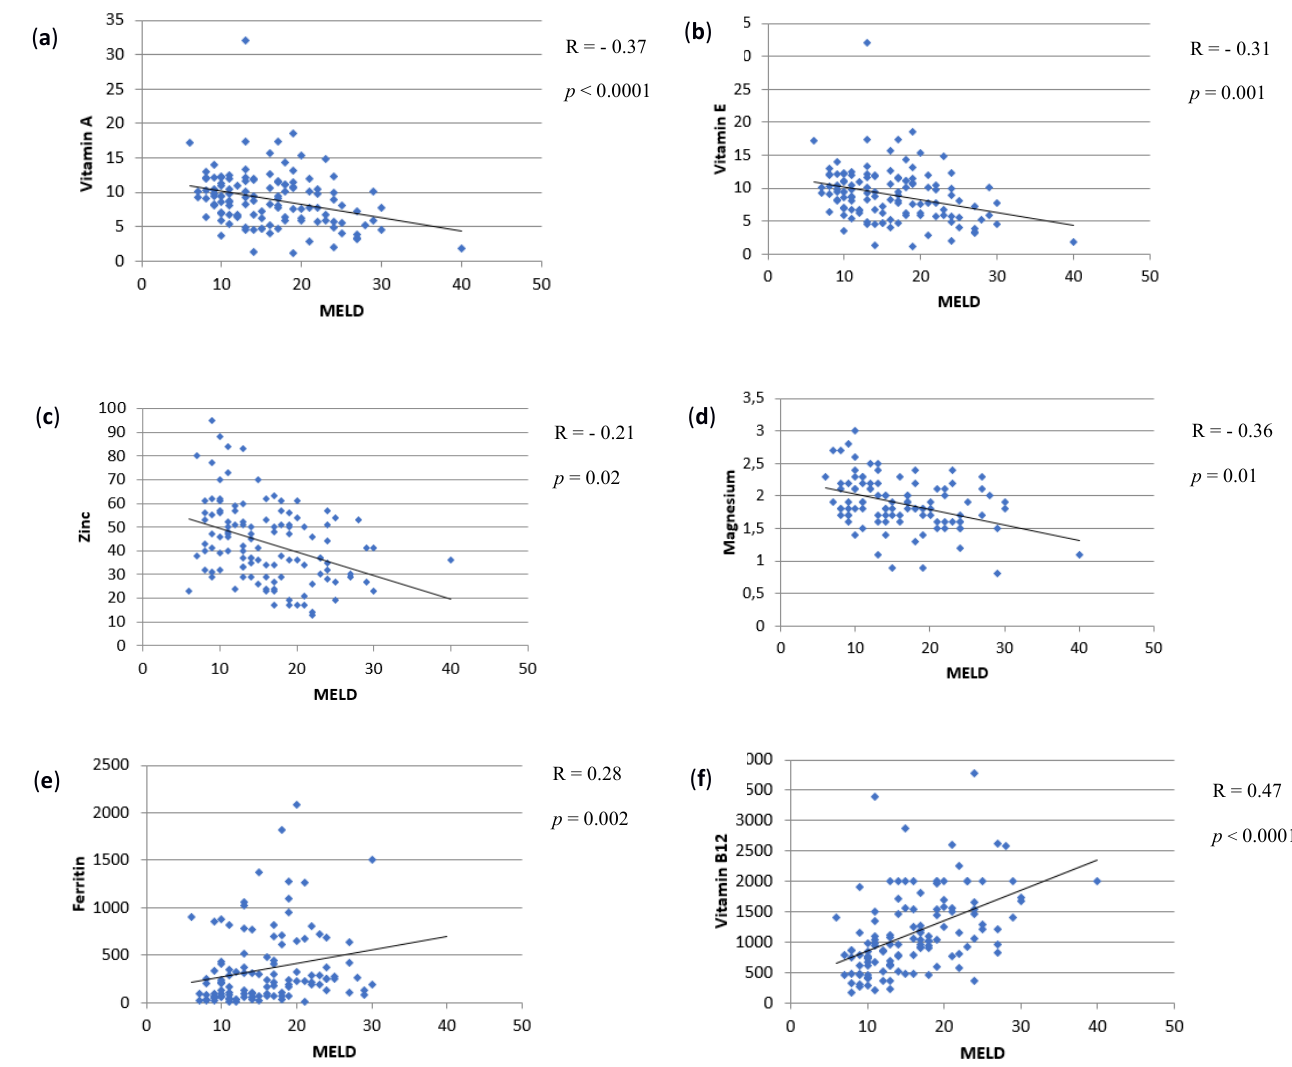
Figure 2. Scatter plots of the correlations of MELD score with the micronutrients that reached statistical significance. R is the correlation coefficient. ( a ) MELD score and vitamin A (negative correlation, R = –0.37), ( b ) MELD score and vitamin E (negative correlation, R = –0.31), ( c ) MELD score and zinc (negative correlation, R = –0.21), ( d ) MELD score and magnesium (negative correlation, R = –0.36), ( e ) MELD score and ferritin (positive correlation, R = 0.28), ( f ) MELD score and vitamin B12 (positive correlation, R = 0.47).